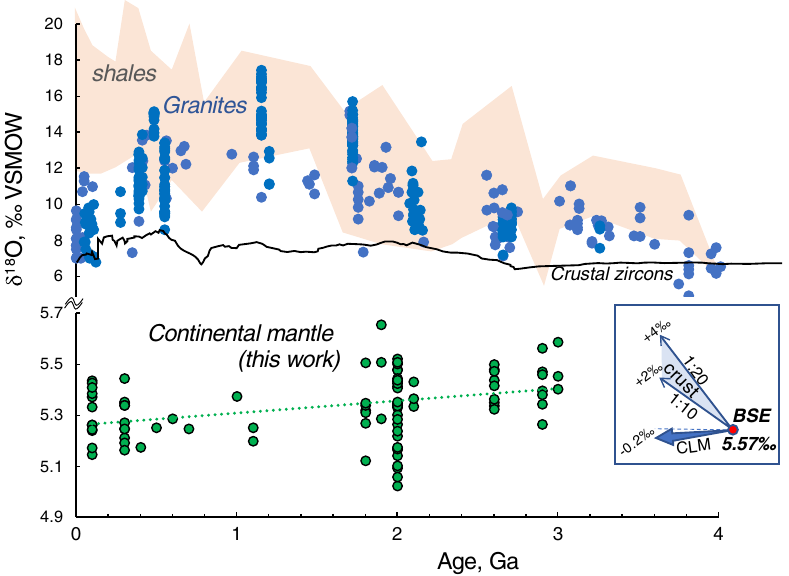
Fig. 6 Co-evolution of the continental lithospheric mantle (CLM, this work) and the Earth ’ s crust as expressed by three proxies: granites, bulk shales 57 , and zircons 67 . Note change in δ 18 O scale. Inset shows mass balance of CLM and crust during growth and evolution; 1:10 and 1:20 are assumed crust/CLM proportions based on the modern average lithospheric thickness of 150 km. BSE is estimated in this work and corresponds to the starting point of crustal growth after the Giant Impact. Unidirectional temporal loss of low- δ 18 O to the large reservoir of CLM helps to explain the accumulation of heavy δ 18 O in the crust and potentially hydrosphere (e.g., 57 –